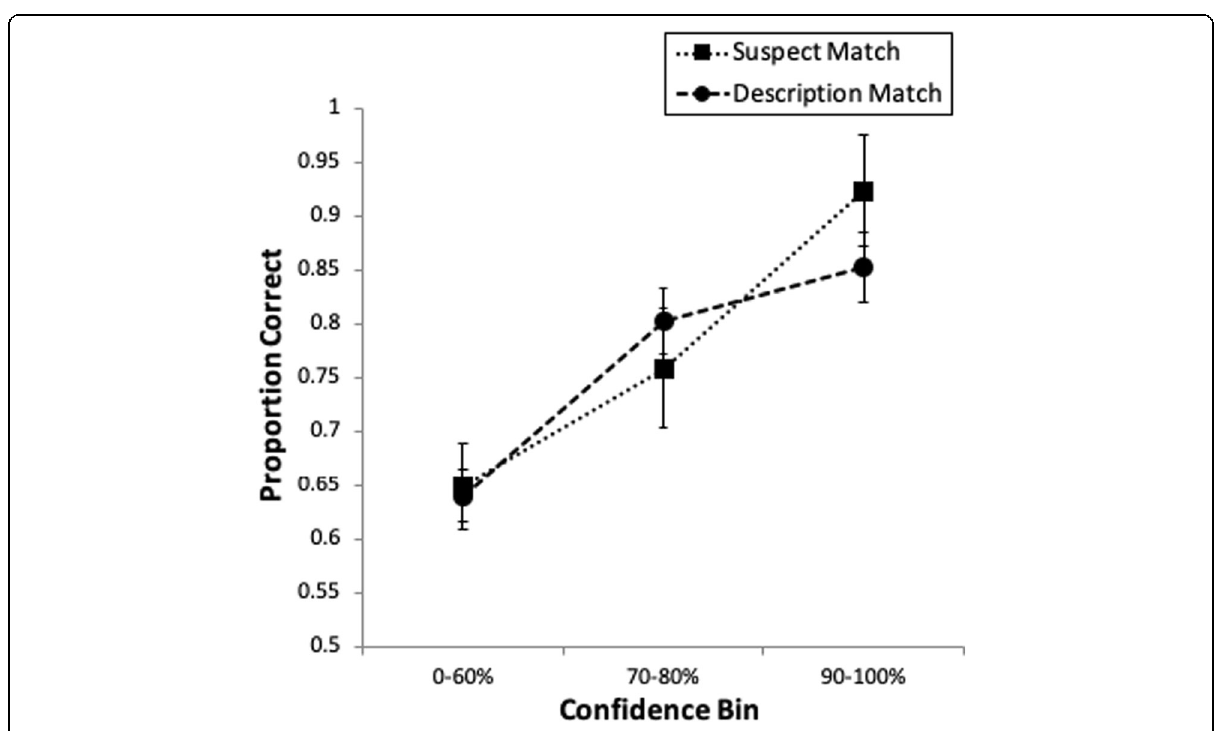
Fig. 5 CAC data from Experiment 2. The bars represent standard errors. Proportion correct on the y axis is #correct IDs/(#correct IDs + #false